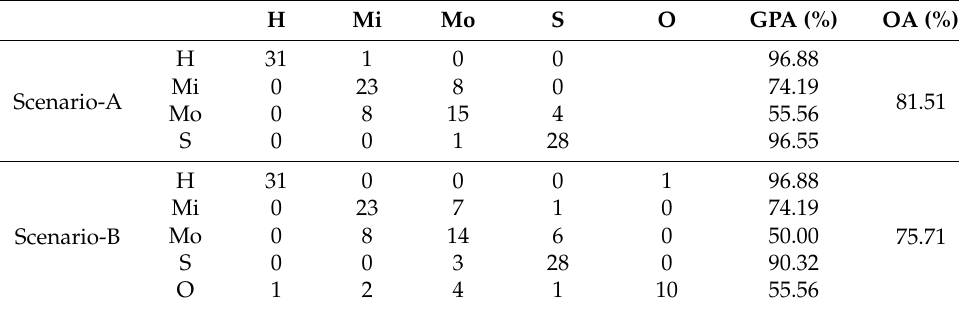
Table 4. The OA and the GPA values of the validation